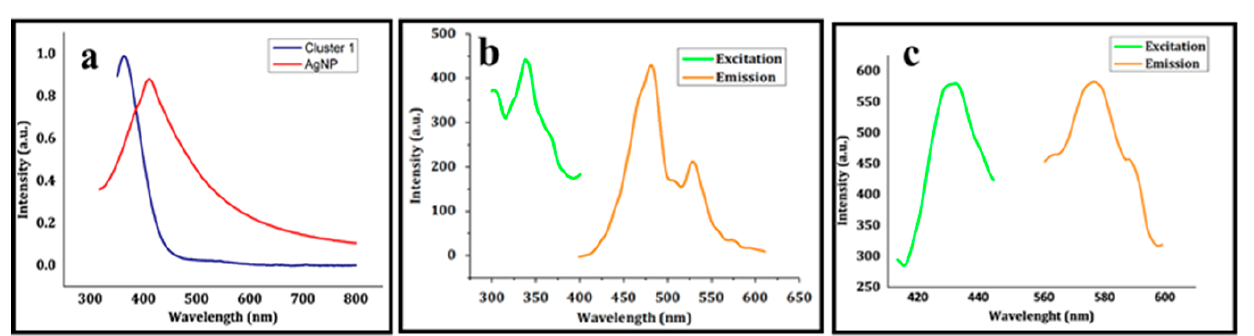
Figure 4. ( a ) SEM micrographs of AgNPs. ( b ) TEM micrographs of AgNPs. ( c ) Particle size distribu- tion of AgNPs. ( d ) EDX spectrum of AgNPs.